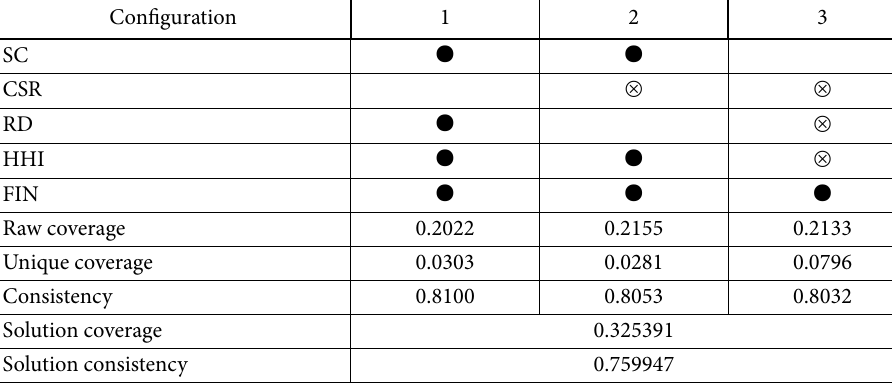
Table 3. Configurations leading to high-level risk-taking Configuration